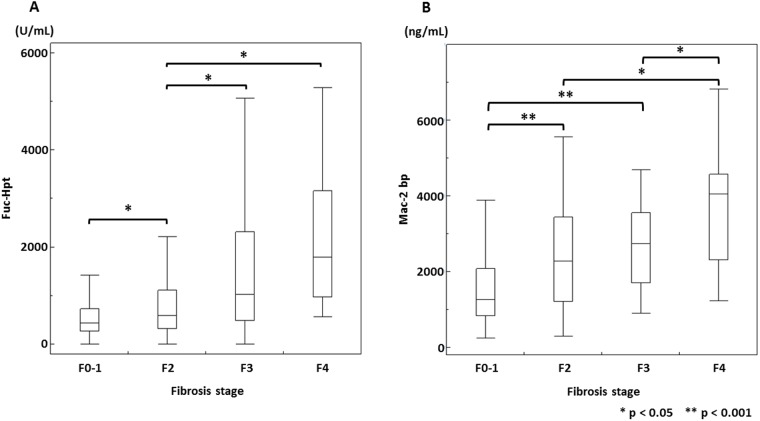
Box-and-whisker plot of the serum Fuc-Hpt (A) and Mac-2 bp (B) levels for each liver fibrosis stage.The top and bottom of each box represent the first and third quartiles, respectively, with the height of the box representing the interquartile range, covering 50% of the values. The line across each box represents the median. The error bars show the minimum and maximum values. The statistical analysis was performed with the Wilcoxon rank sum test. * P < 0.05. ** P < 0.001.